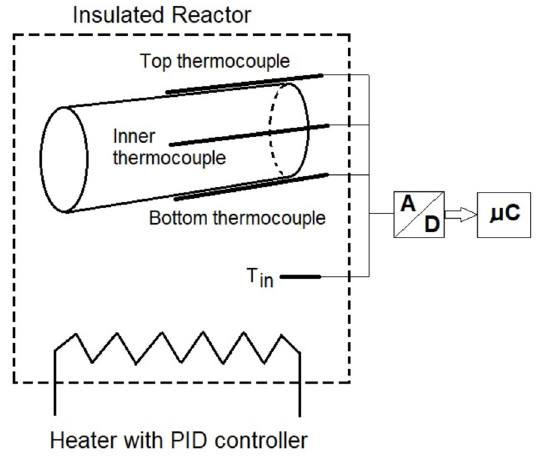
Figure 1. Temperature distribution inside an infinite rod.